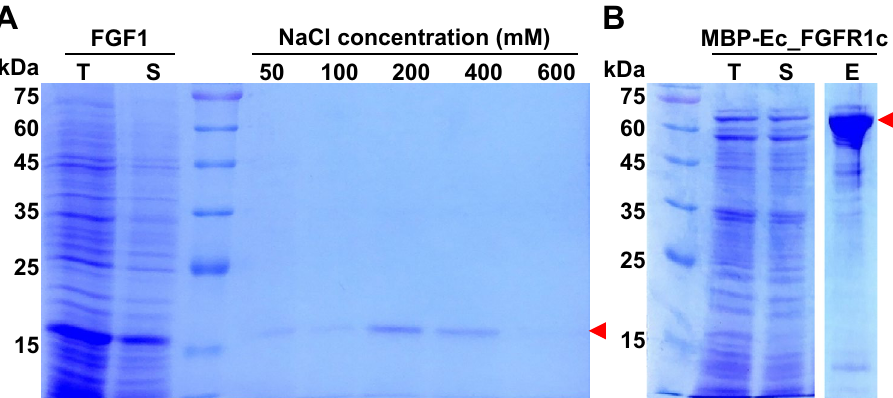
Figure 3. Purification of fibroblast growth factor 1 (FGF1) by receptor affinity using the amylose resin-bound maltose-binding protein (MBP)-fibroblast growth factor receptor 1c isoform (Ec_FGFR1c) protein. The soluble fraction of the recombinant E. coli BL21(D3) harboring pET24a-hFGF1 was loaded onto the column packed with amylose resin-bound MBP-Ec_FGFR1c. FGF1 was eluted from the resin using a stepwise gradient of NaCl ( A ) in repeated-batch mode. After all elution steps for FGF1 were completed, MBP-Ec_FGFR1 was finally stripped from amylose resin using 10 mM maltose in phosphate-buffered saline (PBS) ( B ). Red arrows indicate the target protein obtained. T, S and E denote total, soluble and elution fraction, respectively. The full length of gel image of Fig. 3B before image editing is shown in supplementary Fig. S1.